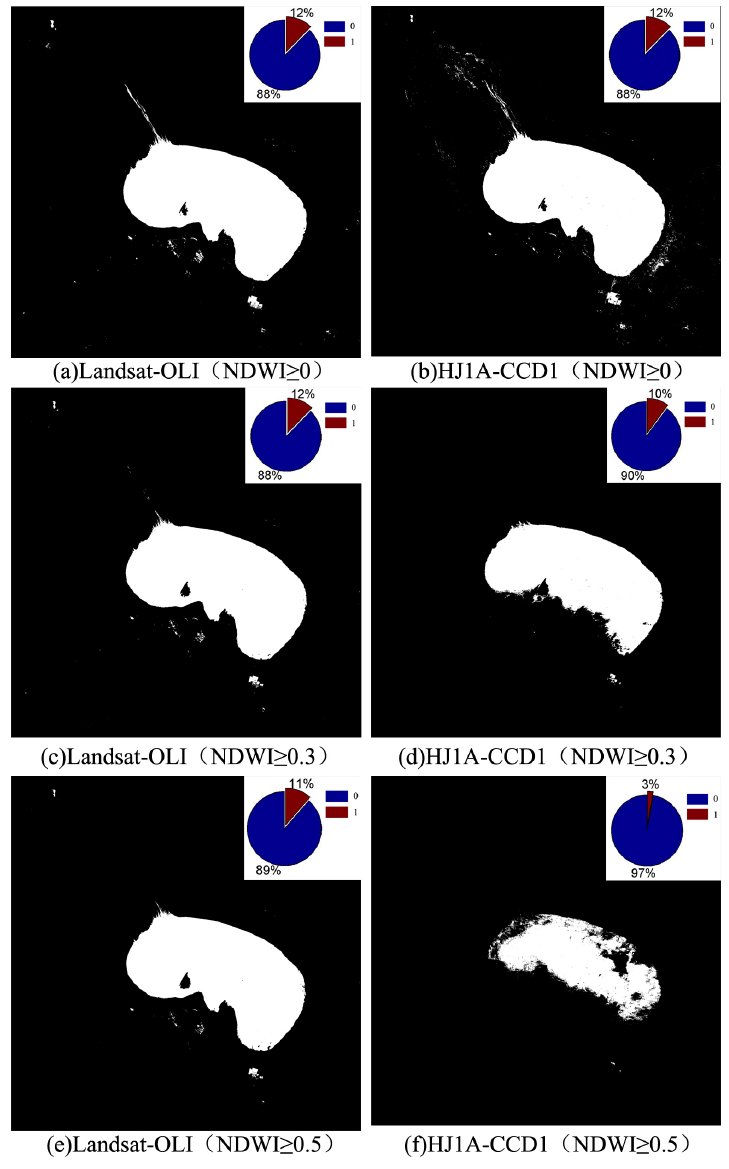
Figure 11. NDWI images of Landsat-OLI and HJ1A-CCD1 at different